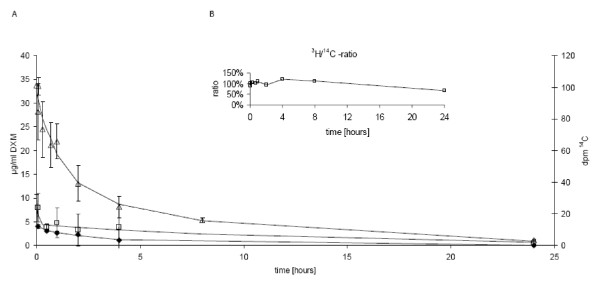
Pharmacokinetics of liposomal and free dexamethasone phosphate in rats. (a) A dose of 4 mg/kg liposomal dexamethasone phosphate (DXM-P) (open squares) or free DXM-P (diamonds) was injected intravenously into rats, and the appearance of the converted dexamethasone (DXM) was monitored in plasma. In a separate experiment, radiolabelled liposomal DXM-P (triangles) was injected into rats and their pharmacokinetics was followed using 14C-1,2-dipalmitoyl-sn-glycero-3-phosphocholine (DPPC). (b) Integrity of liposomal DXM-P. Radiolabelled liposomal DXM-P was injected as in (a) and the additional aqueous phase marker 3H-inuline was analysed. The resulting 3H/14C ratio was plotted with respect to the initial ratio. The constant ratio indicates high carrier integrity in the circulation. Error bars indicate standard deviations.